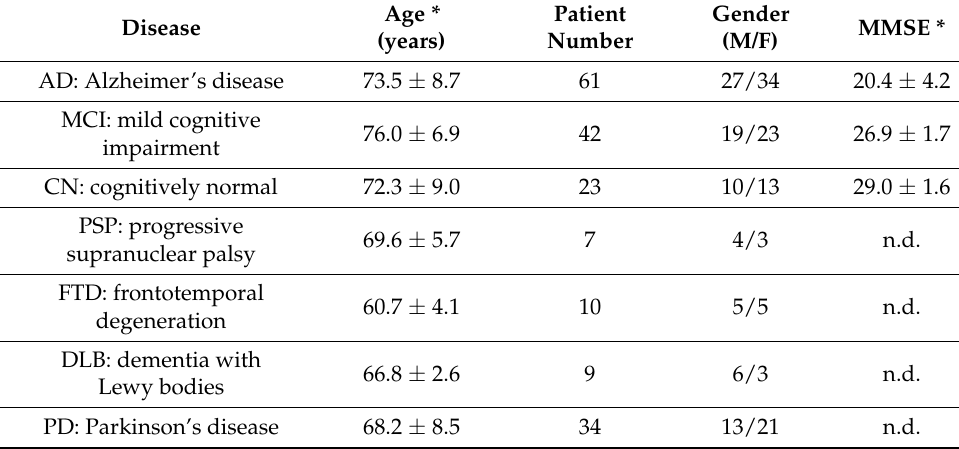
Table 3. Patient